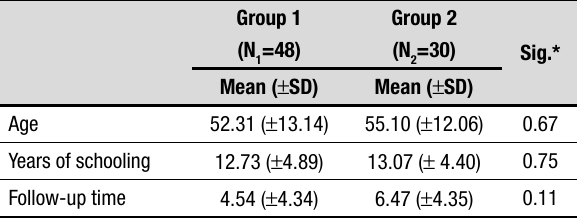
Table 2. Summary measures: age, years of schooling, and follow-up